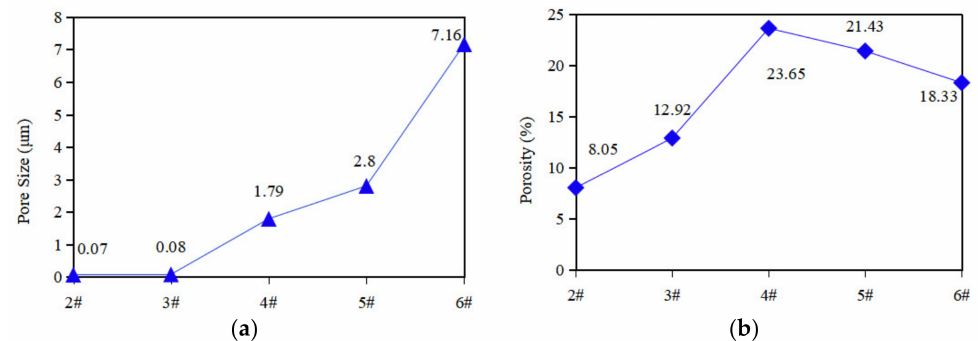
Figure 4. Pore size and porosity of porous samples. ( a ) Pore size of 2#~6# samples; ( b ) Porosity of 2#~6# samples.